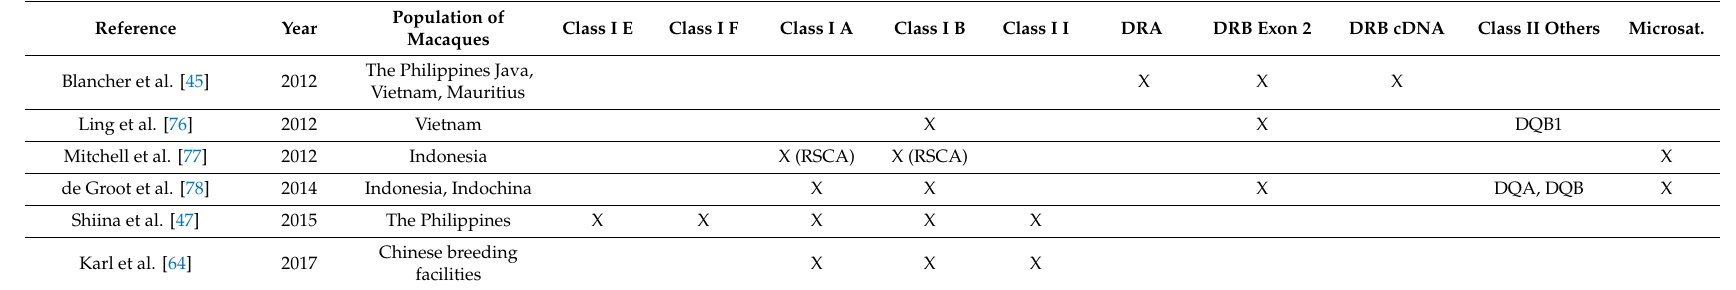
RSCA: (1) Reference strand conformational